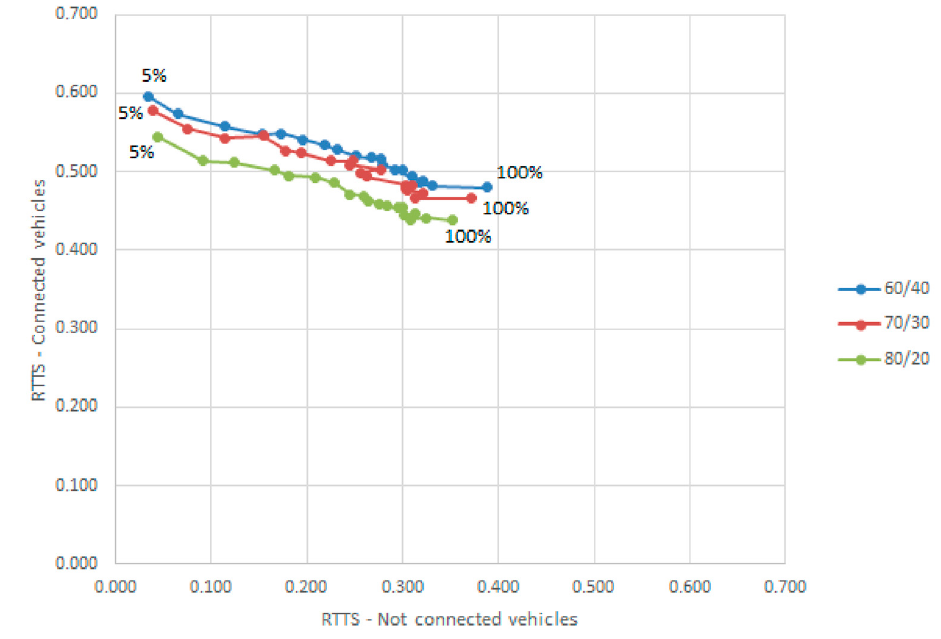
Figure 15. Competition-Cooperation diagram on a daily base in Case B.